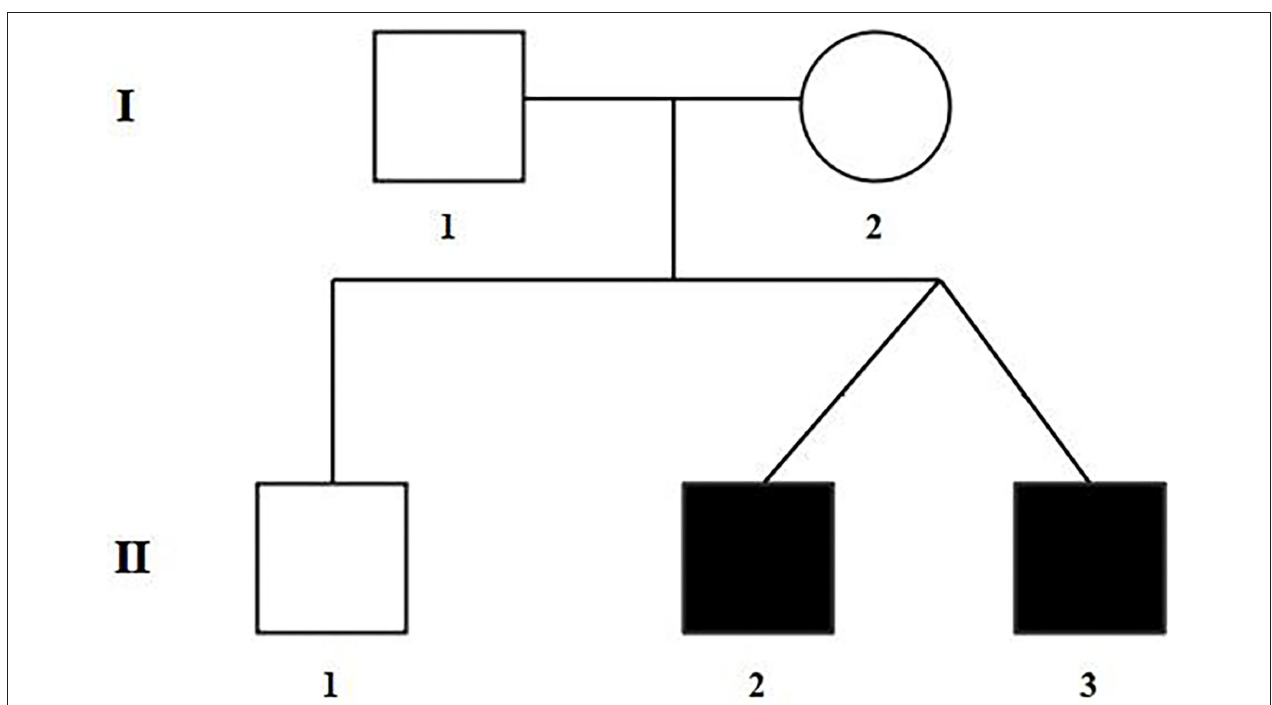
FIGURE 1 | Pedigree of the family with TOF. The filled black symbols represent the affected members.